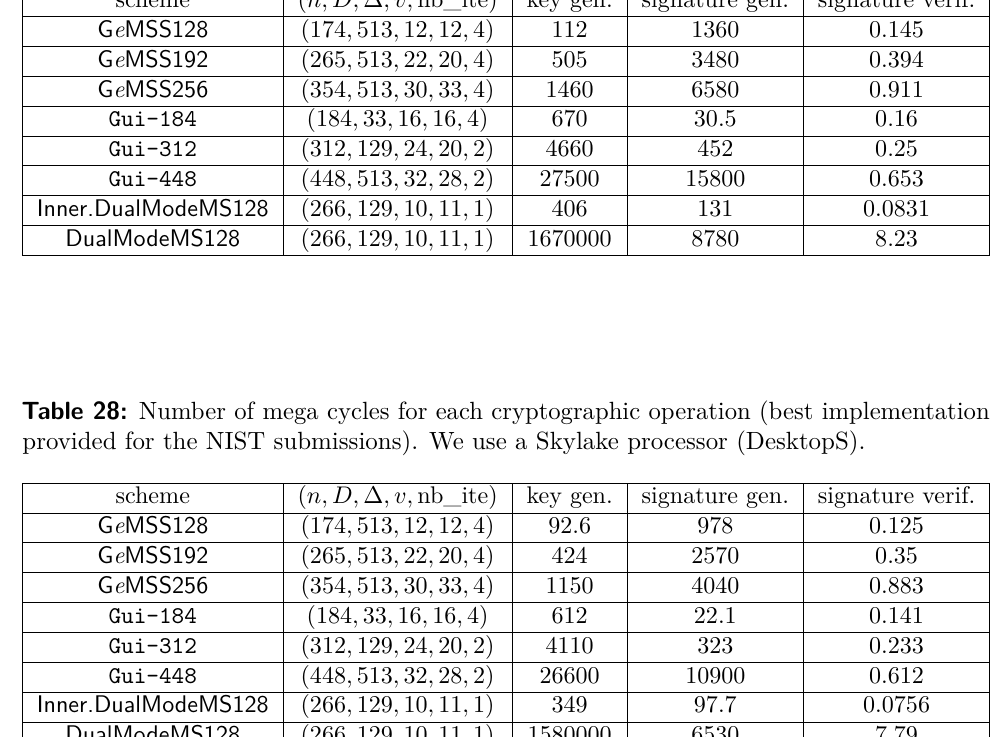
Table 27: Number of mega cycles for each cryptographic operation (best implementation provided for the NIST submissions). We use a Haswell processor (DesktopH). scheme signature gen.